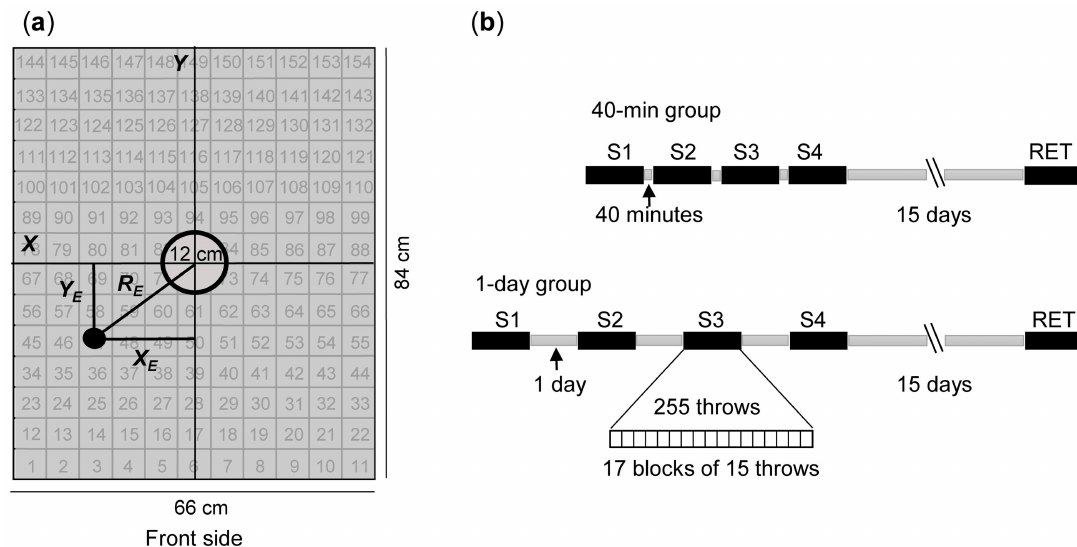
Figure 1. Experimental set-up. ( a ) The target for the underarm throws was marked on a platform placed on the ground. Numbers printed on the platform identified the point of the ball impact. Throwing accuracy was determined by computing the error from the target centre (Radial error, R E ), along the medial-lateral axis ( X E ) and along the anterior-posterior axis ( Y E , throwing axis). ( b ) The structure